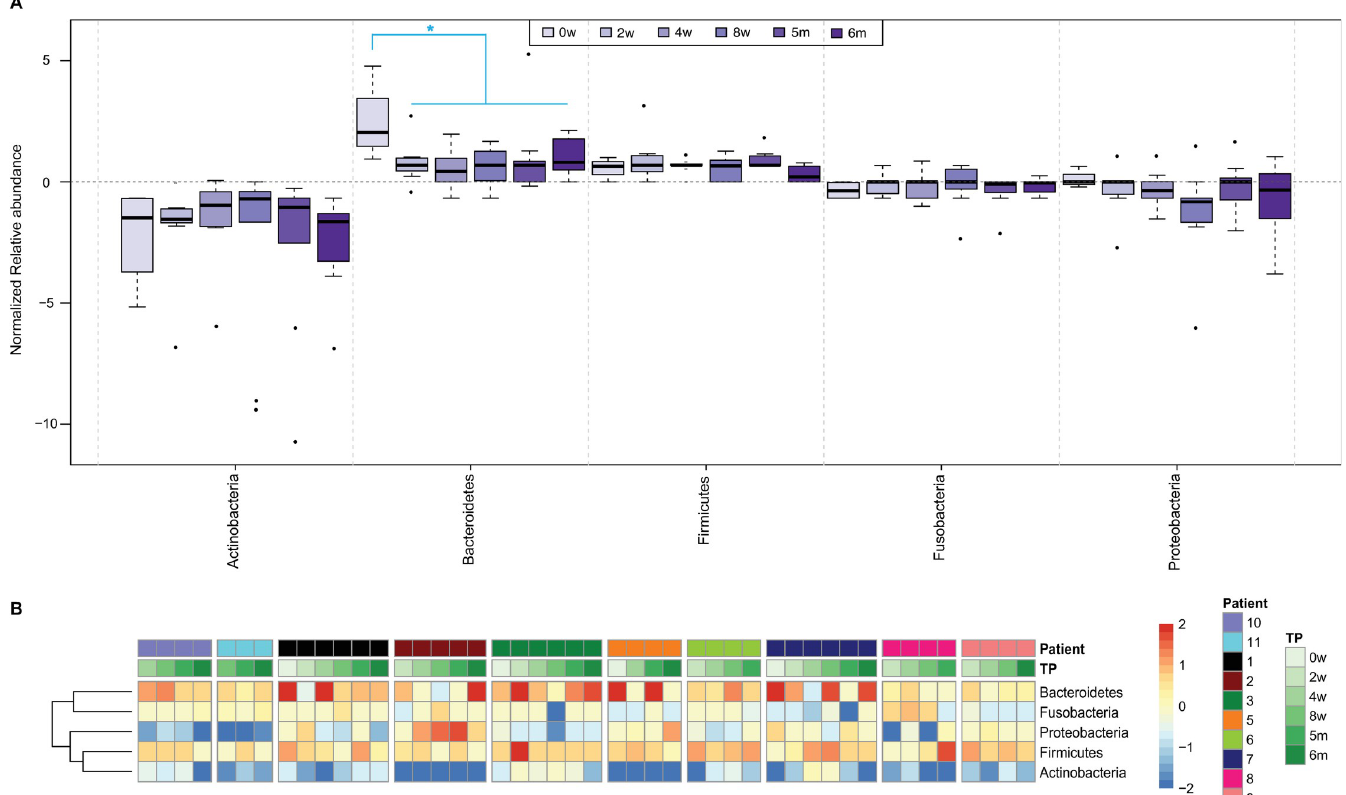
Fig 3. Analysis of samples received from CHUV. A. Phylum abundances per time-points. A significant change could only be observed for Bacteroidetes between time- point 0 and the other five time-points (pairwise t-test, with adjusted p-value < 0.01). B. Heatmap of Phylum abundances across samples and scaled by bacteria. Hierarchical clustering was applied to Phyla. Samples are ordered by patient (different colors) and by time-point (TP).